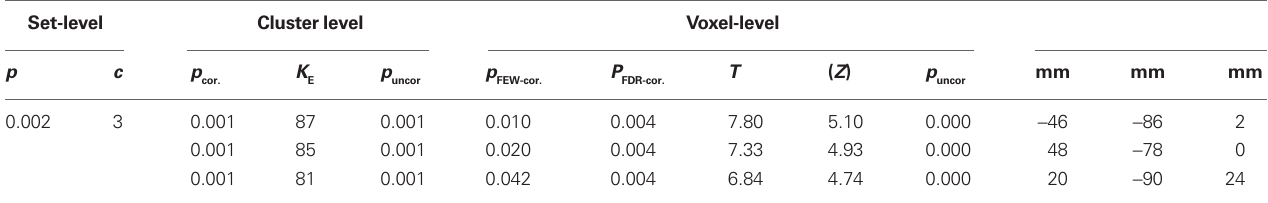
Table 3 | SPM-group analysis for effects of shape, threshold FDR corrected p > 0.001, minimal cluster size of 10. Set-level Cluster level